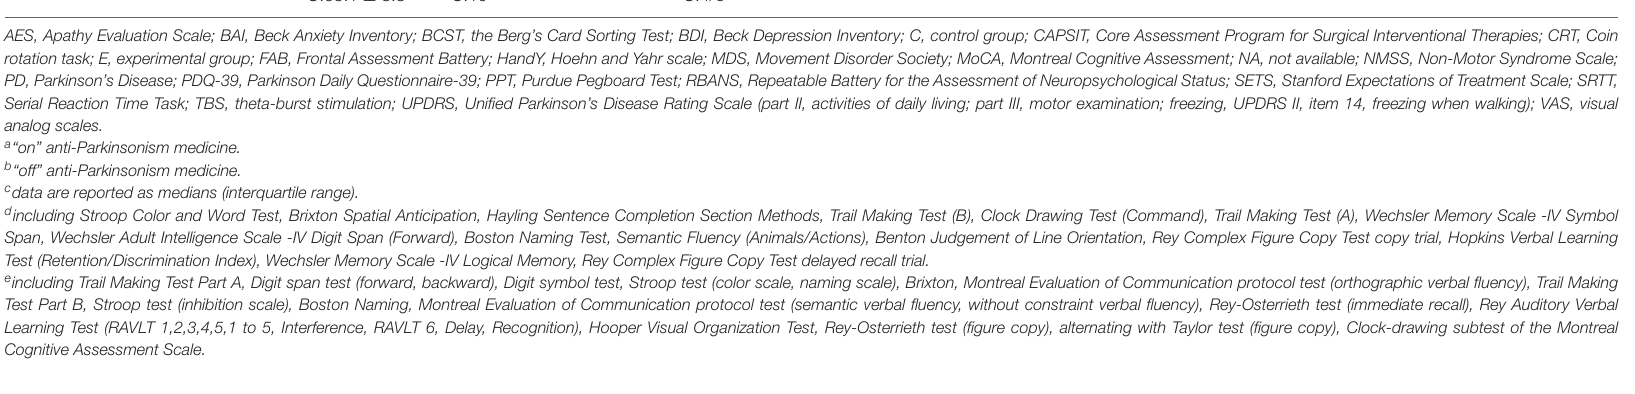
Primary: Neuropsychological Tests battery according to five cognitive domains